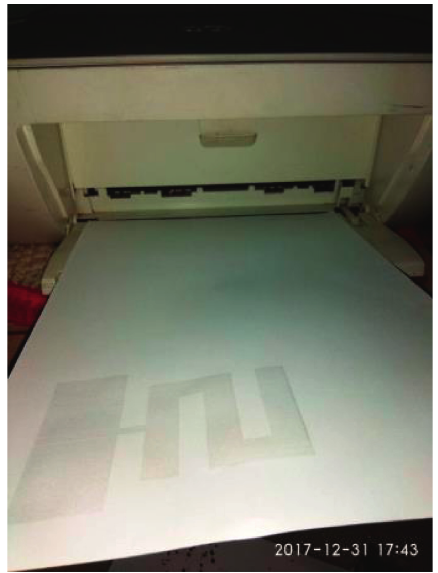
Figure 9: Printing of Z-shaped monopole antenna on paper using HP DJ 3120 printer.